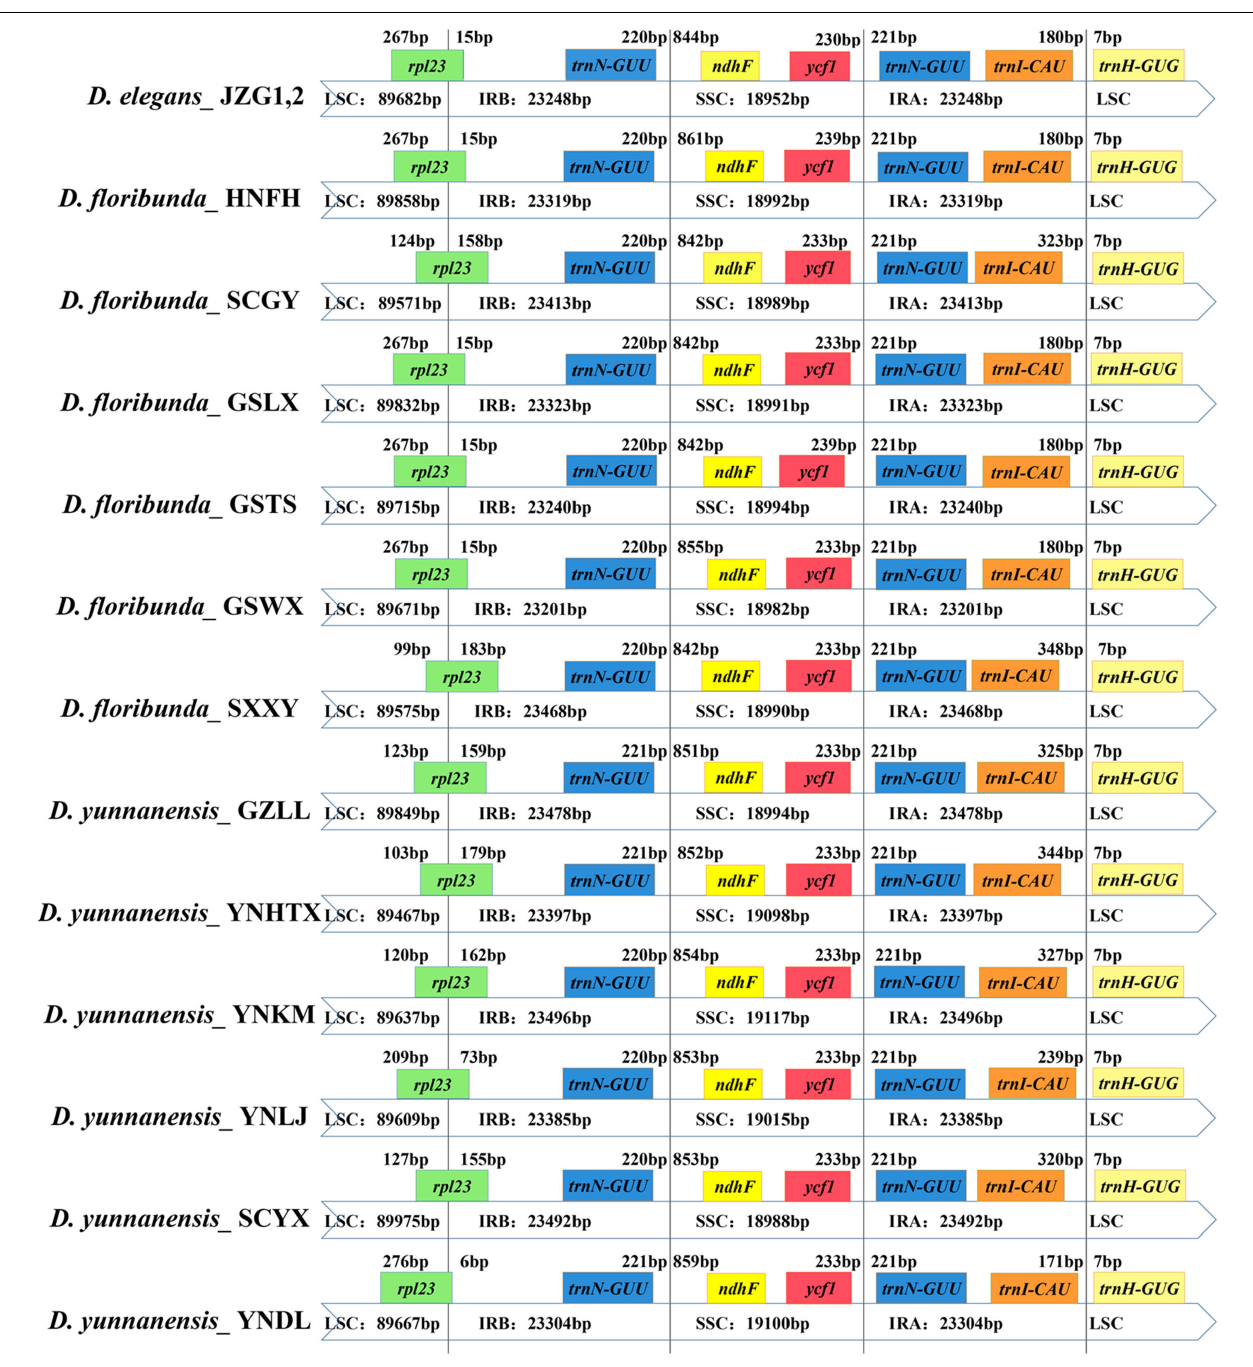
FIGURE 6 | Comparison of the borders of the LSC, SSC, and IR regions in Dipelta plastomes.